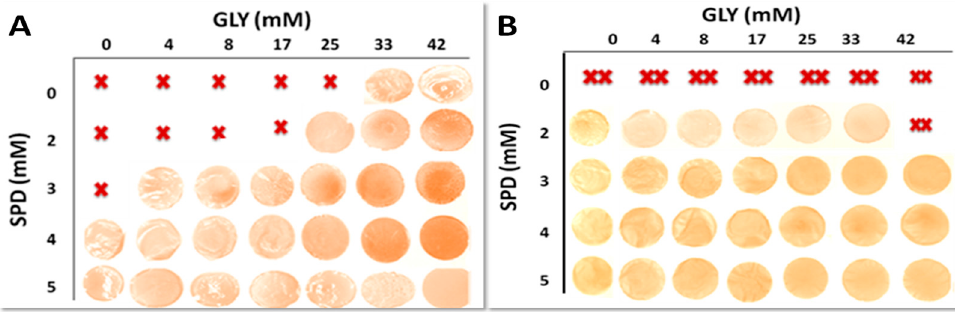
Figure 3. Films obtained by casting BVPC FFSs previously incubated for 30 min, either at 25 °C ( A ) or 80 °C ( B ), at pH 8.0 and in the presence of different concentrations of SPD and/or GLY. Not handleable–either brittle (X) or sticky (XX)-and handleable (photo) films are indicated. Further experimental details are given in the text.